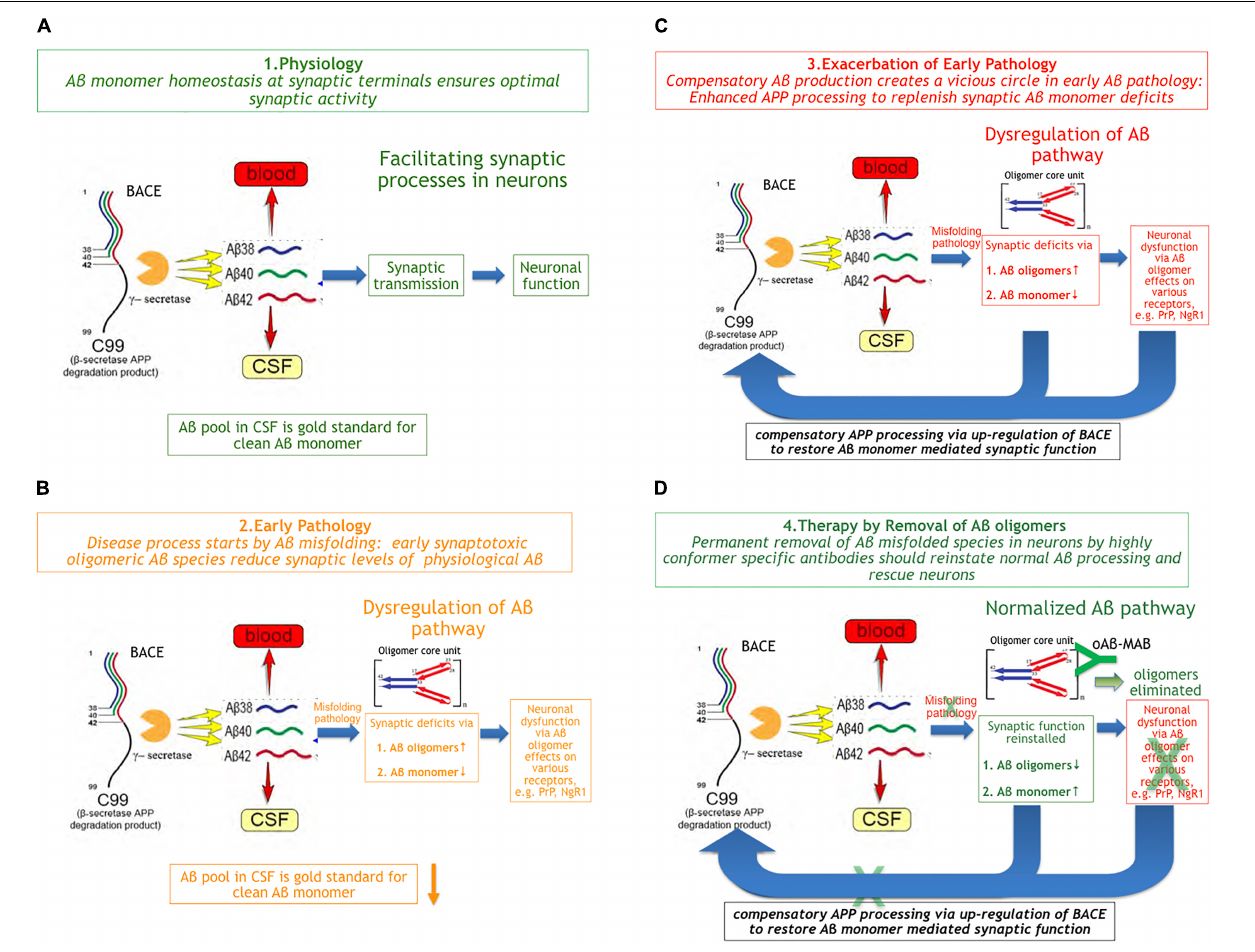
FIGURE 2 | The Beta Amyloid Dysfunction Hypothesis (BAD). (A) Part 1. The Beta Amyloid physiological process [fragments of graphics in panels (A–D) were taken from Patterson et al. (2015)]. In normal individuals, A β monomer is produced, metabolized, and replaced at high rates without formation or residual aggregates. (B) Part 2. The Beta Amyloid pathophysiological process begins. A β monomer folding control is becoming imperfect and A β oligomers begin to form on cost of monomer concentration at synaptic sites. While, in FAD, exhaustion of chaperones can be assumed as the main trigger for pathology, the reason in sporadic AD is unknown so far. (C) Part 3. Exacerbation of pathology through positive feedback loop. In order to maintain A β monomer homeostasis, the loss of A β monomer induces increased A β production by BACE up-regulation, which exacerbates A β misfolding rate: a vicious cycle. (D) Part 4. A β oligomer selective immunotherapy reverses A β dysregulation by removal of misfolded species (oA β -MAB = selective anti A β oligomer monoclonal